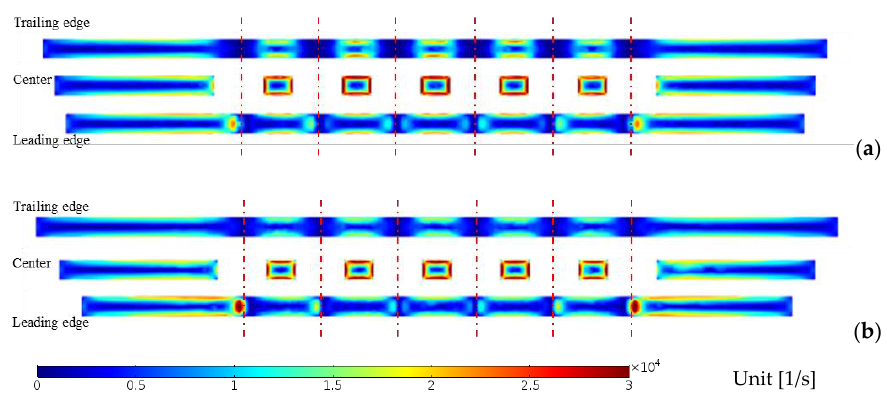
Figure 15. Vorticity magnitude for ( a ) Case 2 and ( b ) Case 8.